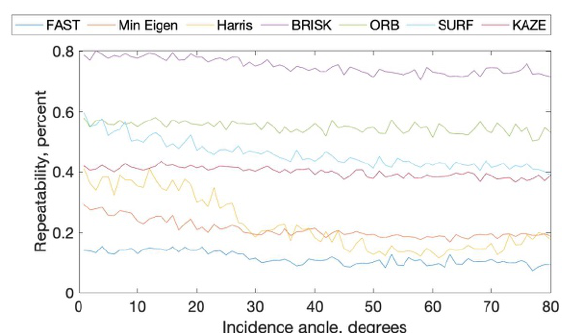
Figure 4. Repeatability of detection when the images is resized by a factor of two.